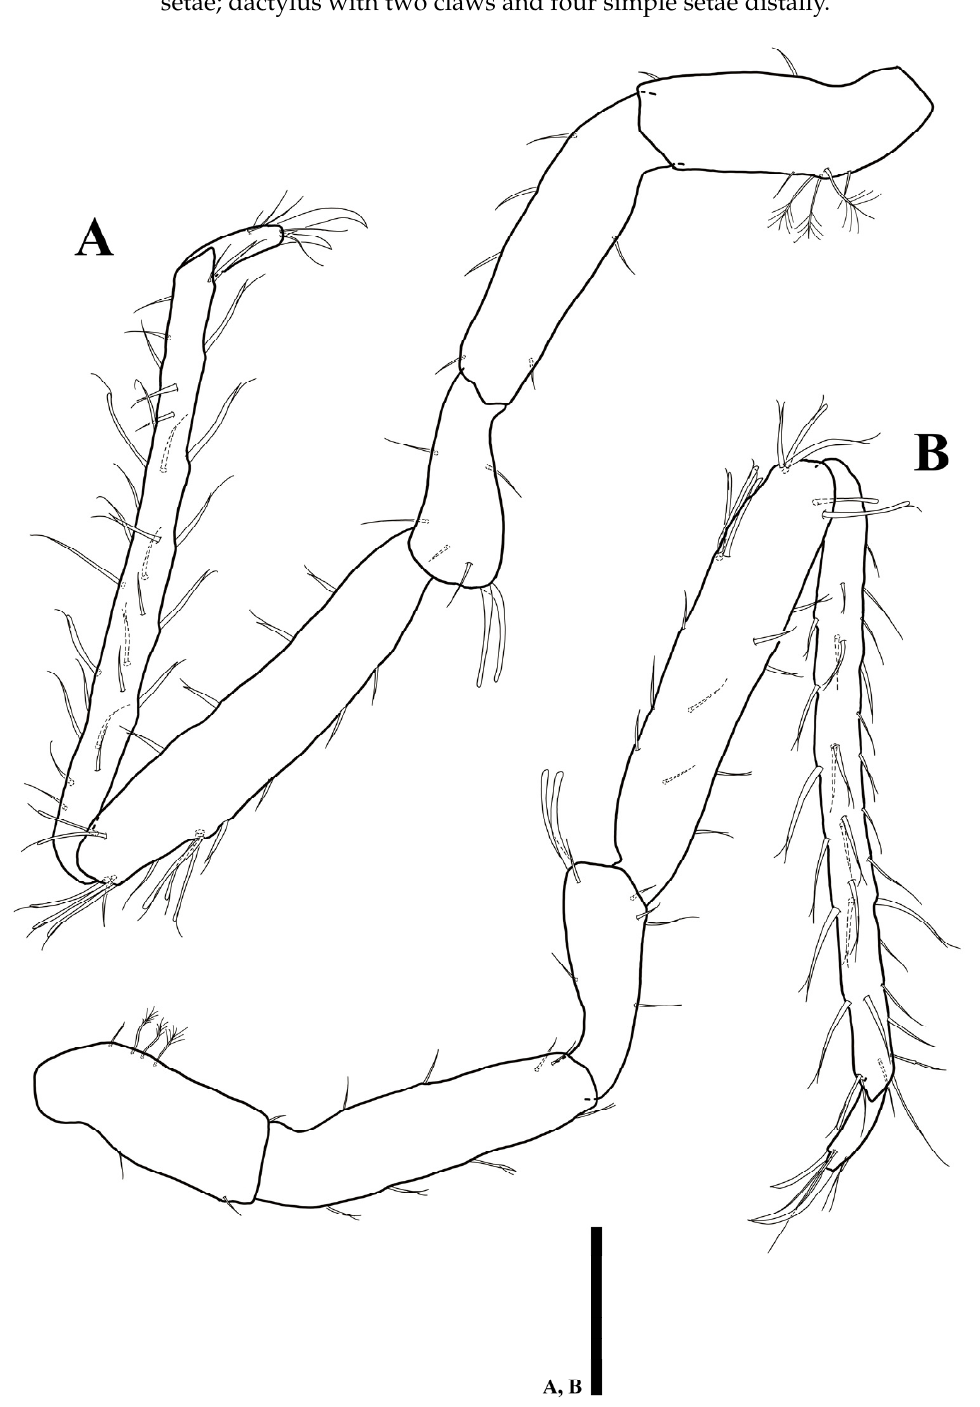
Pereopod 6 (Figure 6A): article L/W ratios 3: 3.5: 2: 4.7: 12.5: 3; basis with four simple and three plumose setae; ischium with six simple setae; merus with five simple and two robust setae; carpus with four simple and 14 UB setae; propodus with 14 simple and 13 UB setae; dactylus with two claws and four simple setae distally.